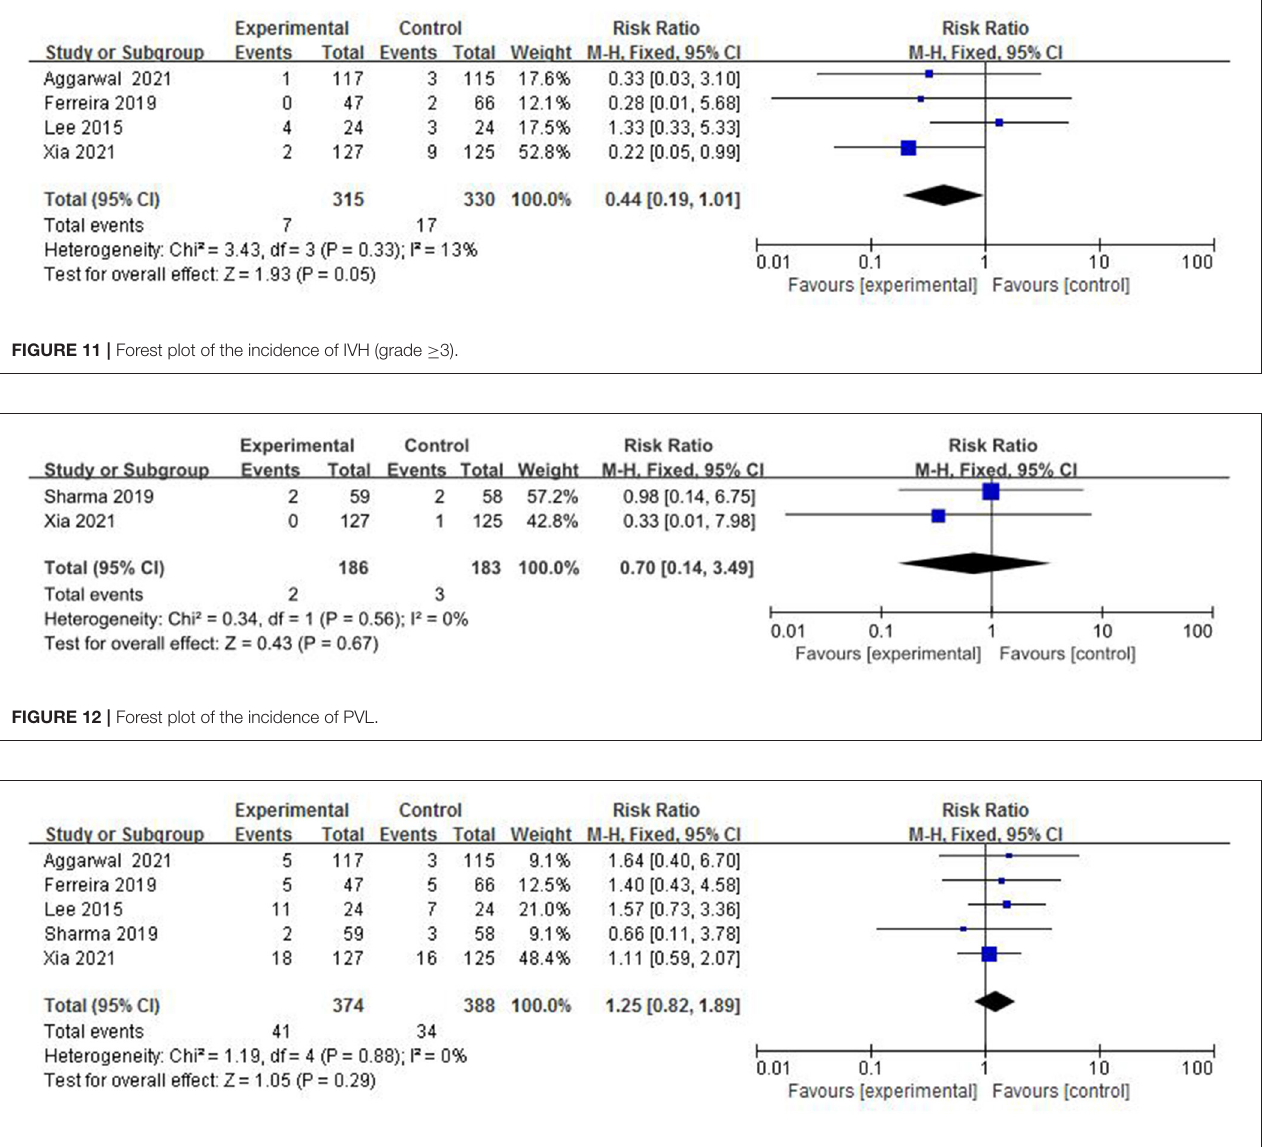
FIGURE 13 | Forest plot of the incidence of